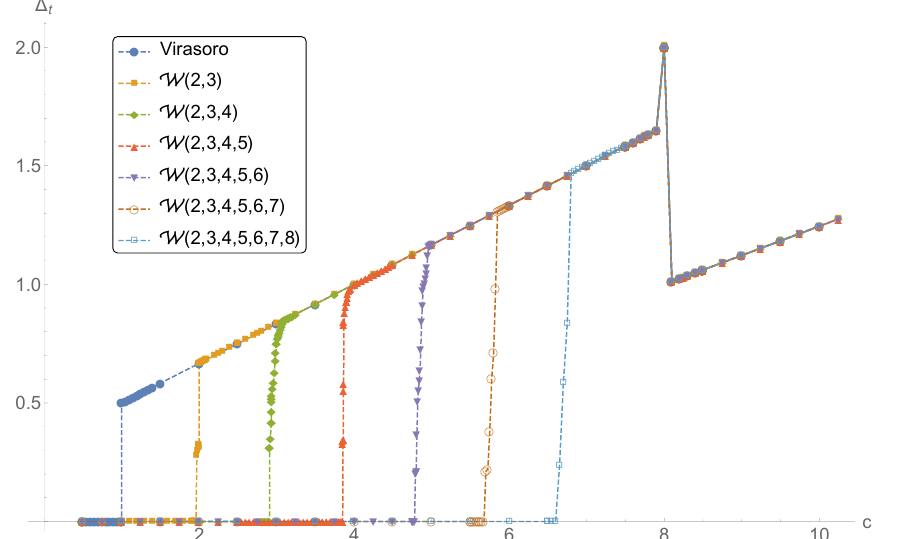
Figure 18. Numerical bounds on twist gap with various W -algebra. We assume the presence of the conserved currents of j (cid:21) 1 in the